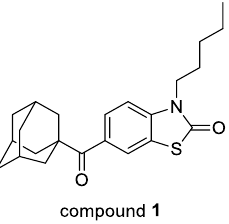
Figure 32. Chemical structure of compound 1.